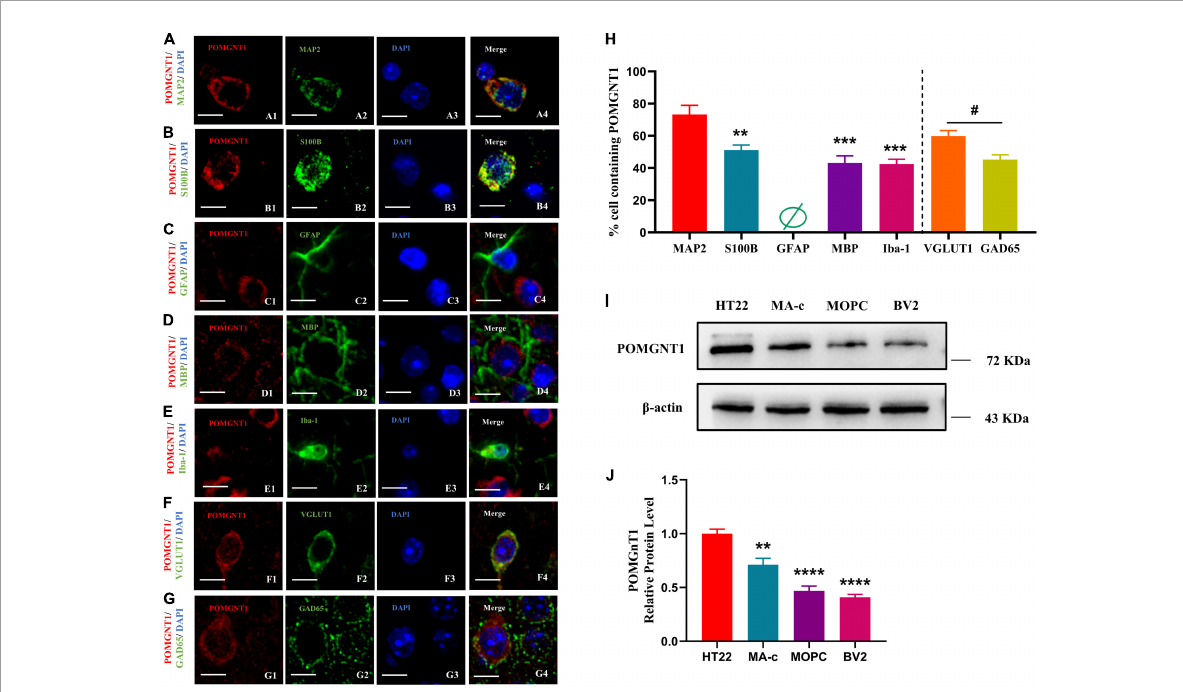
FIGURE4 Cellular localization of POMGNT1. (A–I) Dual immunostaining of POMGNT1 (red) and neuronal glial cell subtype-specific markers (green) in the coronal brain sections of the cerebral cortex, including MAP2 for mature neurons (A) , S100B for resting and activated astrocytes (B) , GFAP for activated astrocytes (C) , MBP for oligodendrocytes (D) , or Iba-1 for microglia (E) , VGLUT1 for Glutamatergic neurons (F) , and GAD65 for GABAergic neurons (G) . POMGNT1 expressed in some neuronal glial cell subtype-specific marker-positive cells, including MAP2, S100B, MBP, Iba-1, GAD65, and VGLUT1, suggesting POMGNT1 may distribute in mature neurons, astrocytes, oligodendrocytes, microglia, glutamatergic neurons, and GABAergic neurons. Nearly no POMGNT1 expressed in the GFAP-positive cells suggesting POMGNT1 may not distribute in the activated astrocytes. N = 6. Scale bars = 20 µ M. (H) Quantification of the percentage of the marker labeling cells containing POMGNT1 shown in panels (A–G) . N = 6. Data are presented as the mean ± SEM; ** P < 0.01; *** P < 0.001 versus the MAP2 group (one-way ANOVA); # P < 0.05 versus the VGLUT1 group (Student’s t -test). (I) The protein expression of POMGNT1 in neurons or glial cells using in vitro culturing, including HT22, MA-c, MOPC, and BV2, was detected by Western blot. β -actin as the loading control. (J) The results of the western blot were quantified. N = 4. Data are presented as the mean ± SEM; ** P < 0.01; **** P < 0.0001 versus the HT22 group (one-way